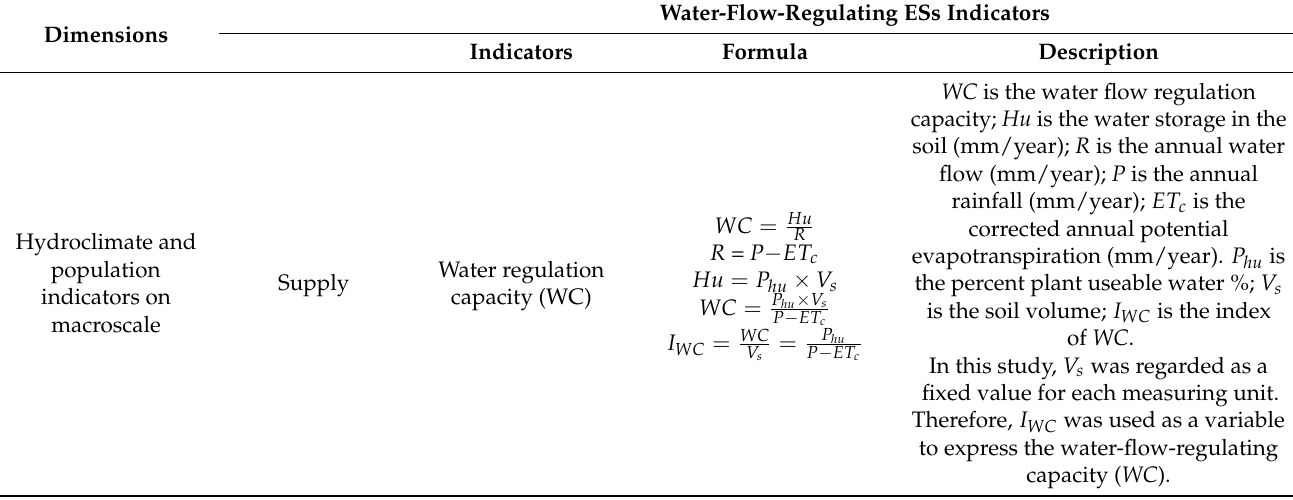
Table 1. Indicators and respective descriptions applied for assessing demand and supply of water- flow-regulating